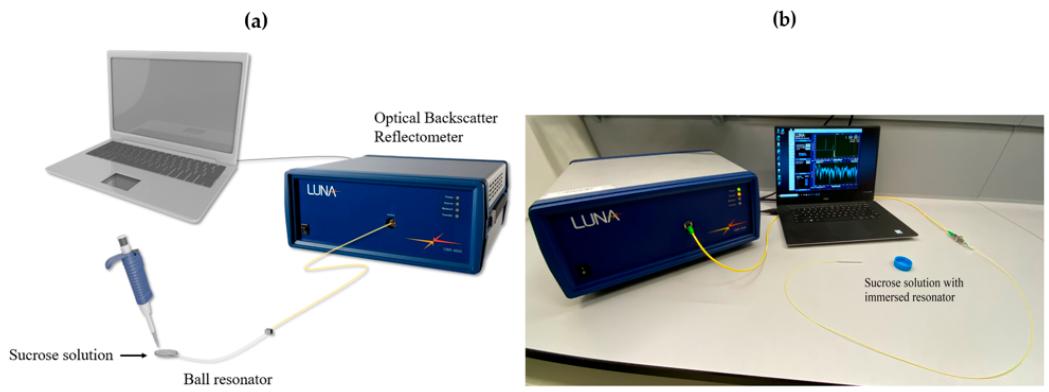
Figure 4. Refractive index measurement with sucrose solution. ( a ) Schematics of measurement procedure setup. ( b ) Photographic image measurement procedure setup.